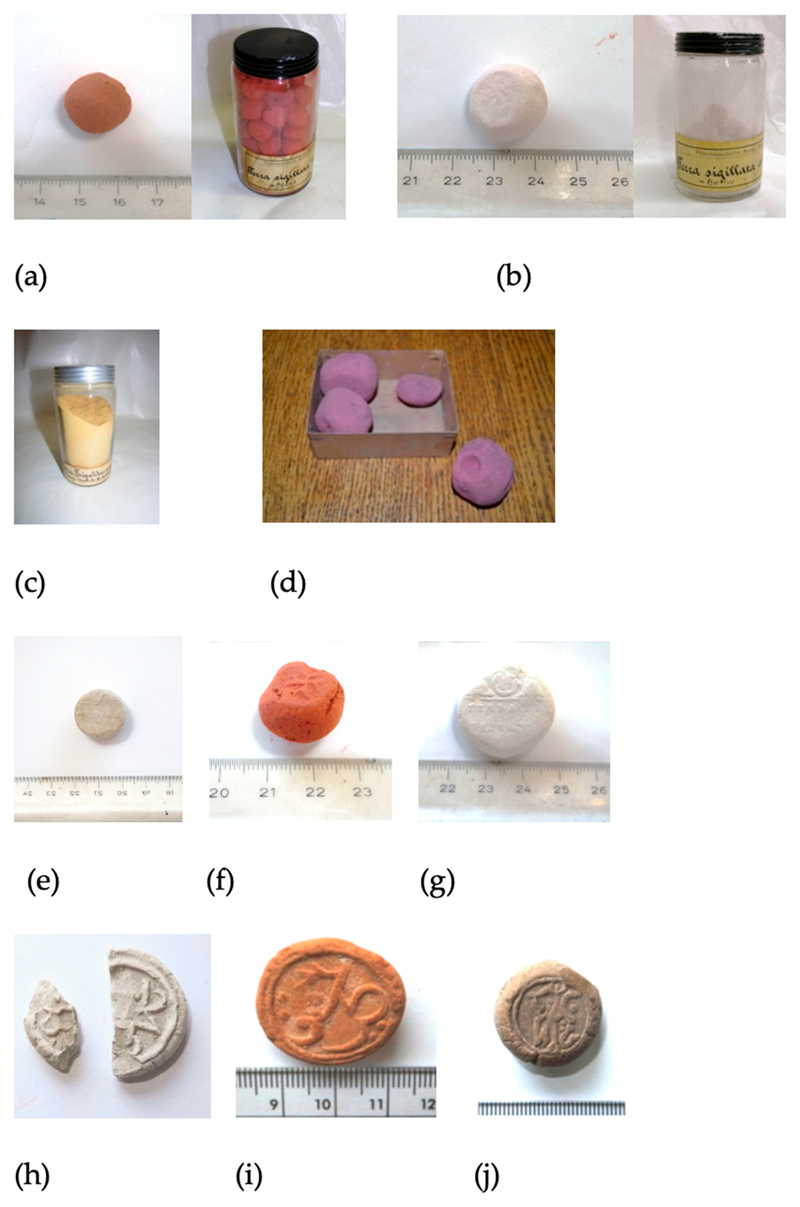
(a) Z-01405. Left: sample received, with no seal. Right: Terra Sigillata rubra, also with no stamped seals; with a label marked: Pharmaceutical Institution, Basel; (b) Z-01406). Left: sample as received. Right: Terra Sigillata alba = bolus; with a label marked: Pharmaceutical Institution, Basel; (c) Z-O1277. Powdered sample; with label marked: Alte Engel-Apotheke St.Gallen (old Angel Pharmacy, St Gallen); (d) Z-1628. Four small samples of purple Terra Sigillata—one sample was analyzed but with inconclusive results so they are not reported here: (e) Z-01627. Terra Sigillata without stamp; (f) Z-01629-1 and (g) Z-01629-2; Terra Sigillata, with faded stamp; label on container bearing the logo of Wespi Pharmacy, Brugg; (h) sample 700.4 (white), (i) 700.17 (red), and (j) 700.18 (yellow-grey), all Lemnian Earths from the collection of the University of Basel Museum of Pharmacy (after Photos-Jones et al. [15]).